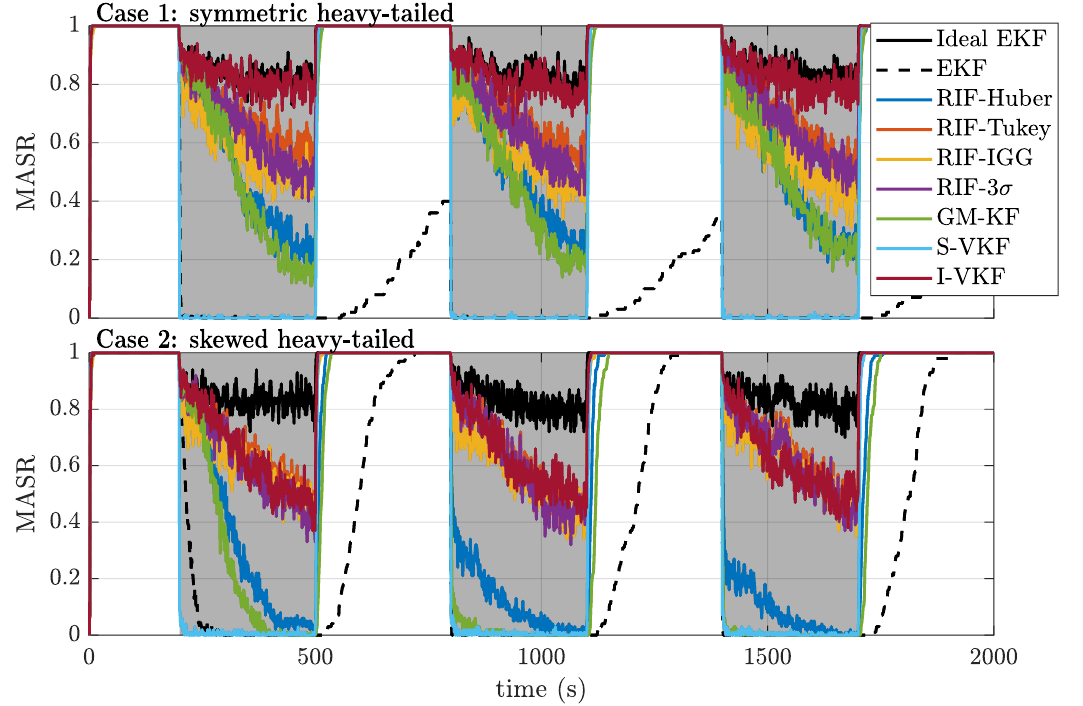
Figure 6. Mean ambiguity success rate (MASR) over time for cases 1 ( top ) and 2 ( bottom ).